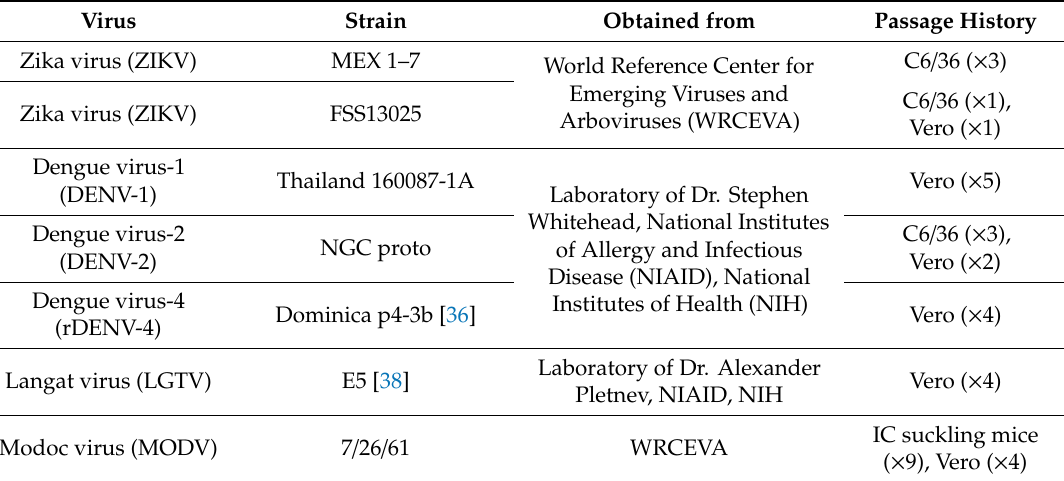
Table 1. Passage history for flaviviruses utilized in this